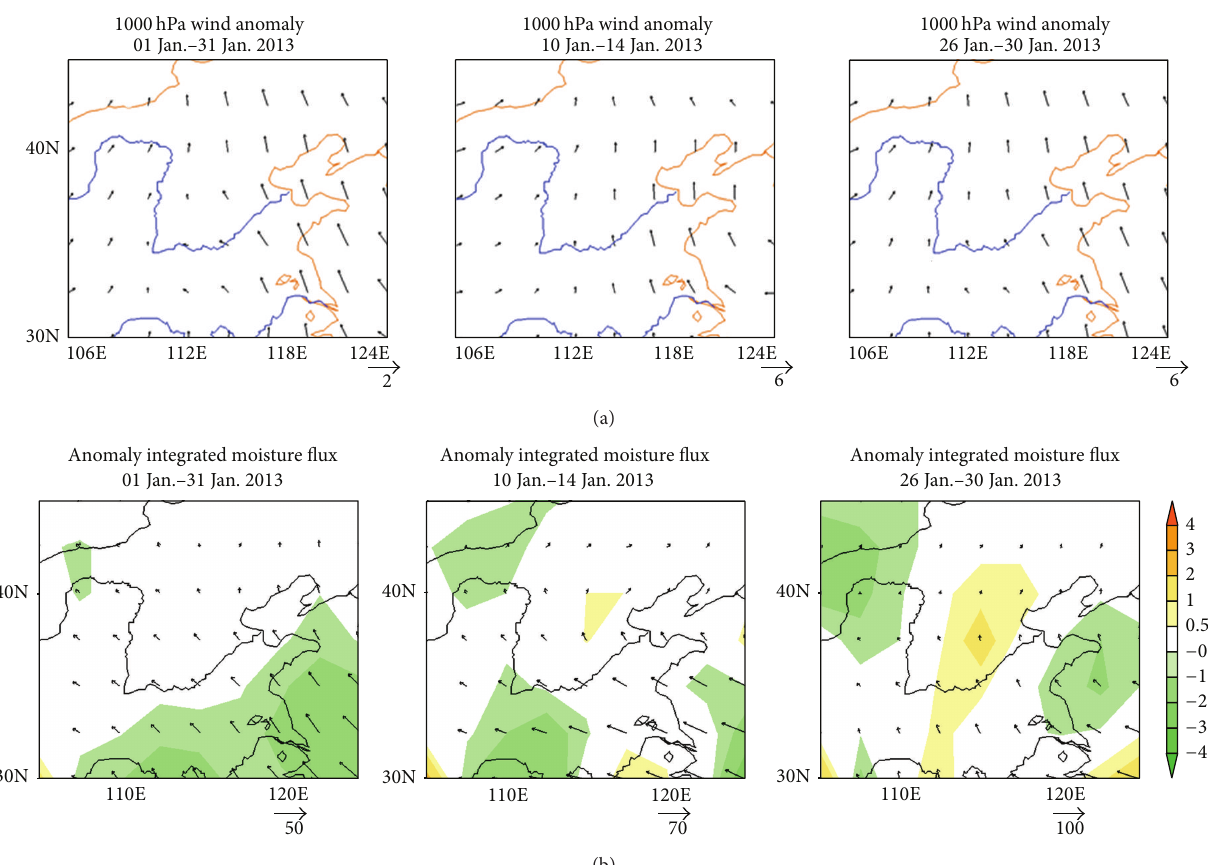
Figure 6: (a) 1000 hPa wind anomaly (vectors; m/s) (b) integrated moisture flux from 1000 to 300 hPa (vectors; kg/(s ⋅ m)) with convergence ( < 0) and divergence ( > 0) (shadings; 10 −5 kg/(s ⋅ m 2 )) for different periods during January 2013 using daily and monthly mean NCEP/NCAR reanalysis data with a 2.5 ∘